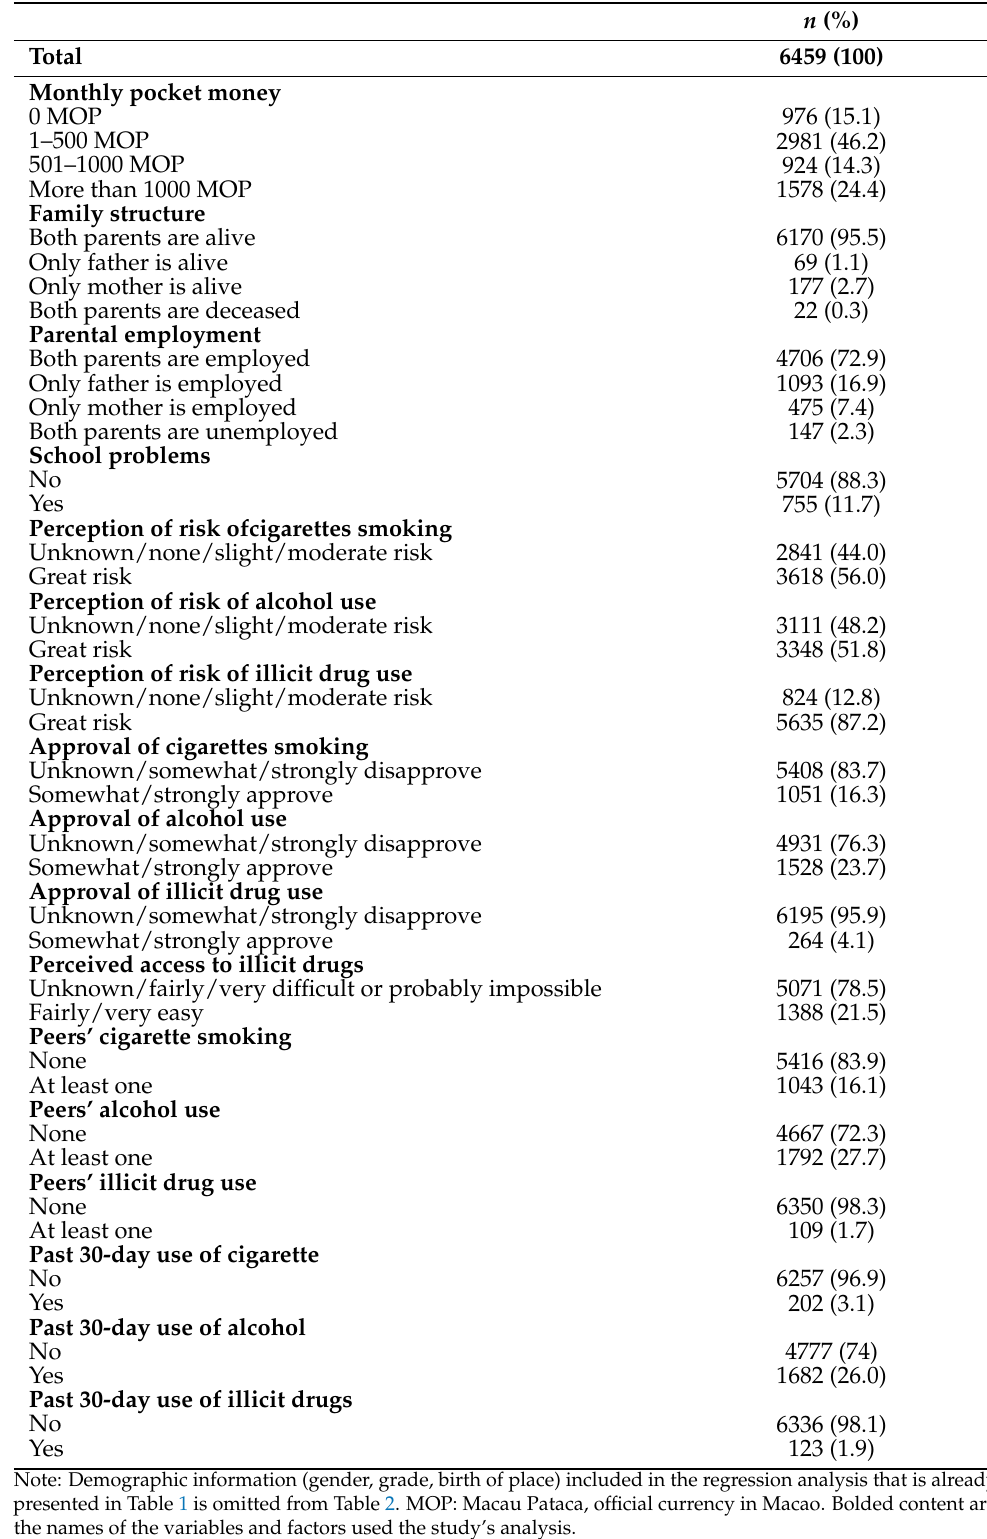
Table 2. Sample characteristics in 2018 ( n =